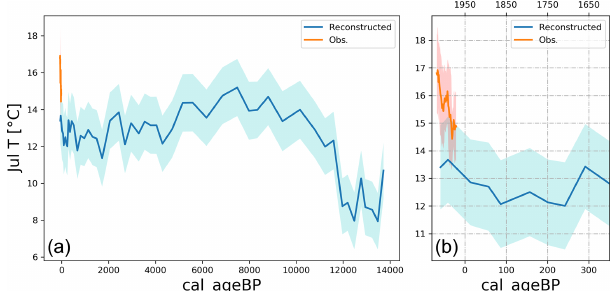
Figure 8. Comparison of current data and reconstructed July mean temperature at the Lake Verdarolo site (see Fig. 1 for location). The blue line is the reconstructed temperature, and the shaded area is the sample-specific estimated standard error associated with the tem- perature reconstruction based on the chironomid assemblage from Samartin et al. (2017). The orange line represents the July mean temperature (1961–2018) retrieved for the grid cell of Lake Ver- darolo from the Emilia–Romagna climate reanalysis Eraclito (11- year running average). The shaded orange area is ± 1 standard de- viation. The full available period is reported on the left, while a zoom into the most recent period (since 1600CE) is shown on the